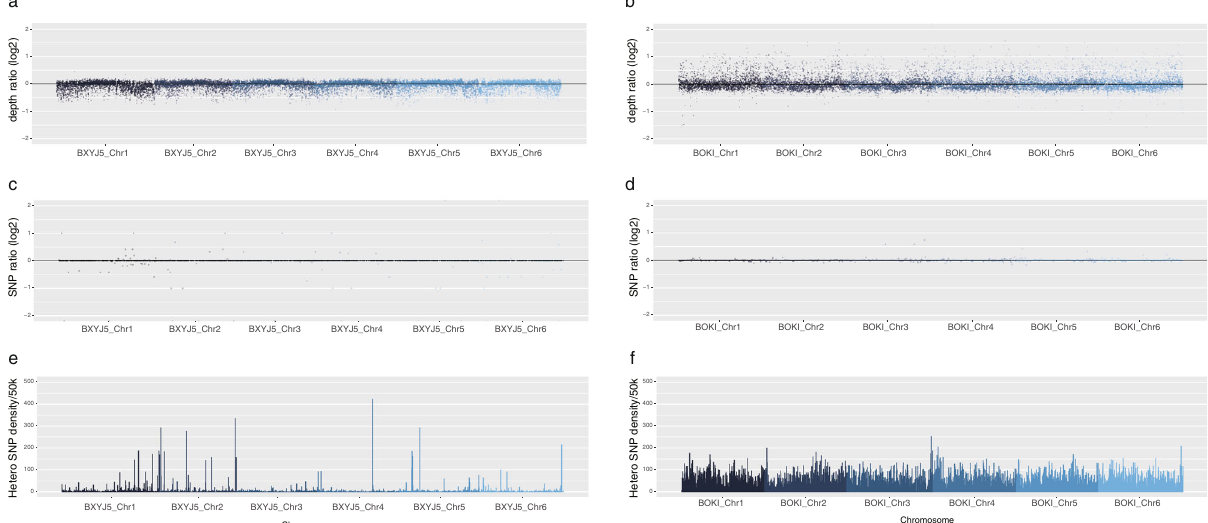
Fig. 2 Sex-biased read-depth and SNP density along the six chromosomes. Depth of coverage was calculated by a 5 kb sliding window and centered by median depth of whole genome. Log2 ratio of read-depth of male sequencing data relative to female/hermaphrodite is plotted ( y axis) across genomic regions ( x axis) for B. xylophilus ( a ) and B. okinawaensis ( b ). Heterozygous SNP density was calculated with 50 kb windows for B. xylophilus female ( e ) and B. okinawaensis hermaphrodite ( f ). Log2 ratio of SNP numbers in male relative to female/hermaphrodite are plotted ( y axis) across genomic regions ( x axis) for B. xylophilus ( c ) and B. okinawaensis ( d fragments were mostly A-T homopolymers. Therefore, the two sexes of B. okinawaensis and B. xylophilus are likely to have essentially identical genomes, and thus no sex chromosomes.